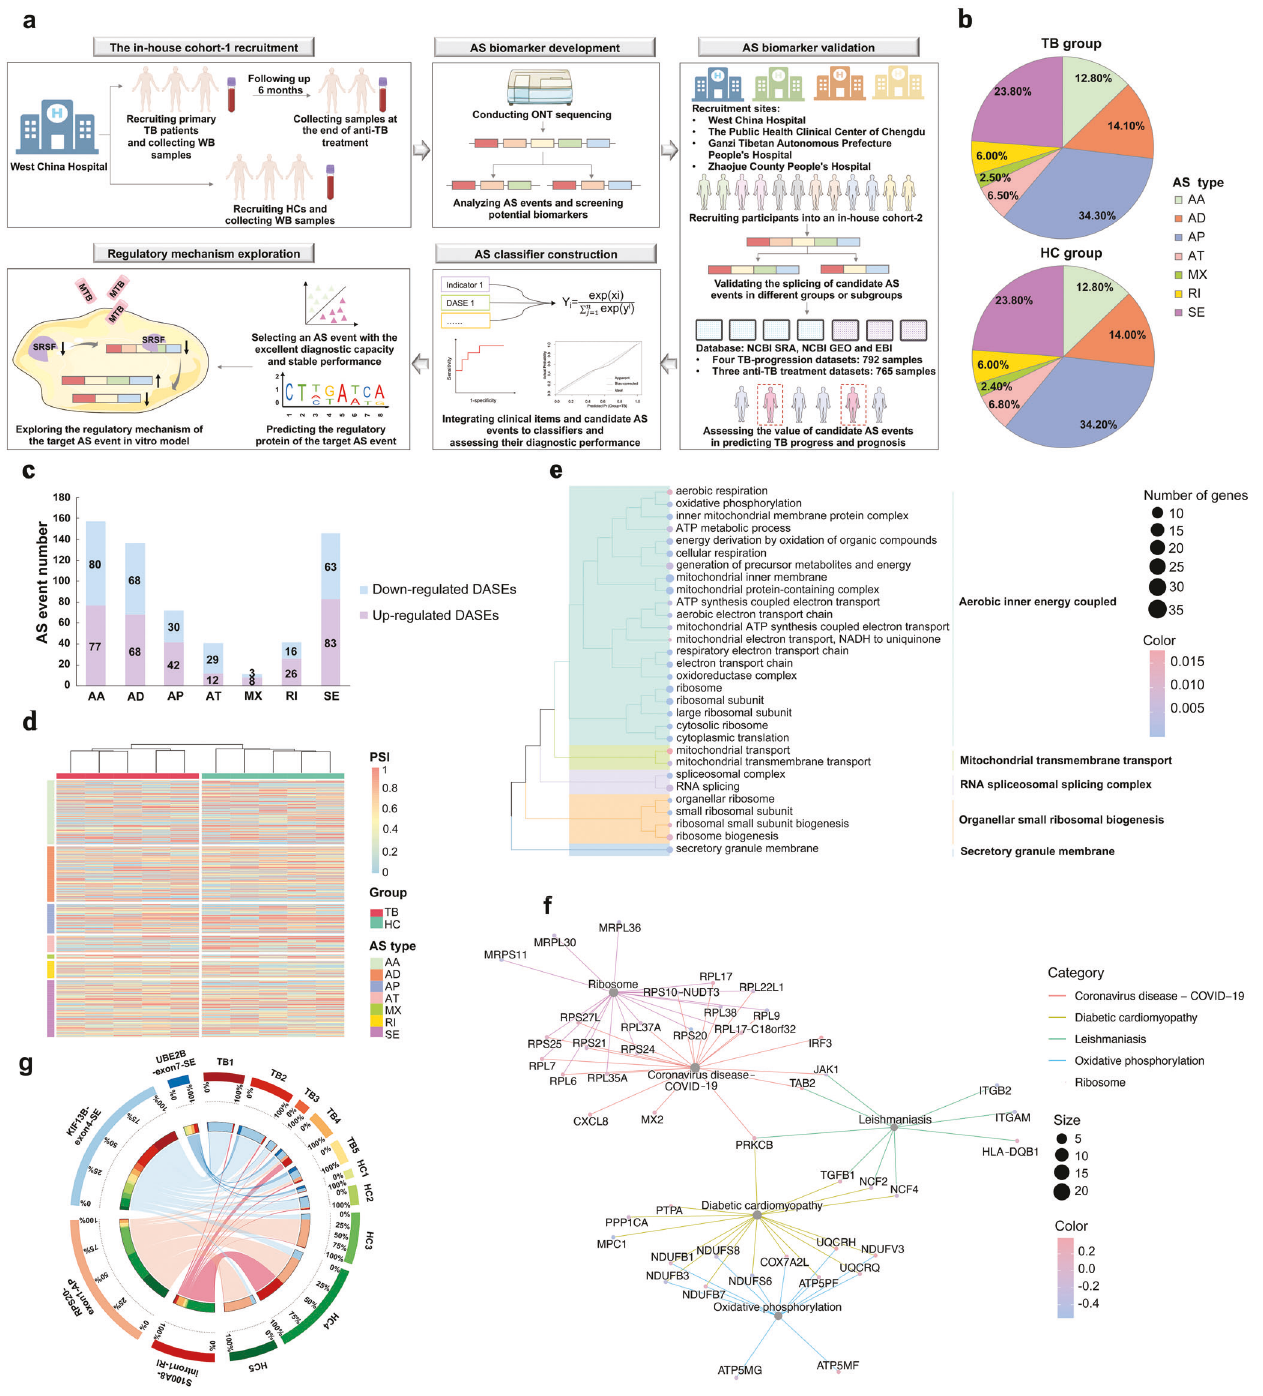
Fig. 1 The splicing pro fi ling of primary TB patients and HCs in an in-house cohort-1 based on ONT sequencing. a The fl owchart of the study design. b Pie chart showing the proportion of alternative splicing types in different groups. c Stacked bar plots of differential alternative splicing events. d Heatmaps showing the PSI values of differential alternative splicing events. e GO enrichment analysis of DASE-related genes. f KEGG enrichment analysis of DASE-related genes. g Circus plots showing the splicing of selected four events in different samples. The left inner circle exhibited the proportion of PSI values of different samples in the accordingly splicing events. The right inner circle exhibited the proportion of PSI values of different splicing events in the accordingly samples. The line thickness inside the circle indicated the proportion described above. TB tuberculosis, WB whole blood, HC healthy control, AS alternative splicing, ONT Oxford Nanopore Technologies, SRSF serine/arginine-rich splicing factor, MTB mycobacterium tuberculosis , DASE differential alternative splicing event; PSI percent spliced in, AA alternate acceptor site, AD alternate donor site, AP alternate promoter, AT alternate terminator, SE skipping exon, ME mutually exclusive exons, RI intron retention, S100A8 S100 Calcium Binding Protein A8, RPS20 Ribosomal Protein S20, KIF13B Kinesin Family Member 13B, UBE2B Ubiquitin Conjugating Enzyme E2